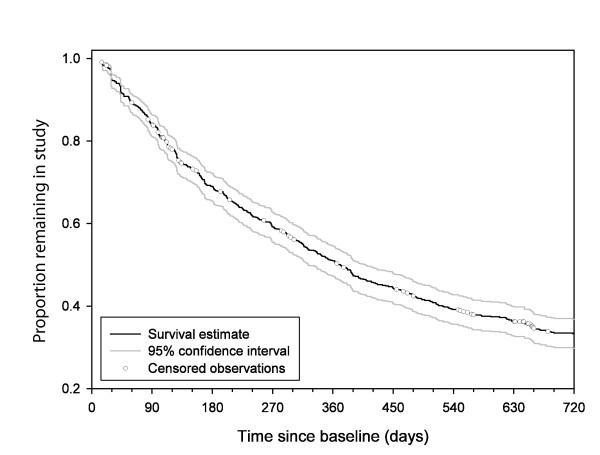
Time to discontinuation of RLAI (n = 784).